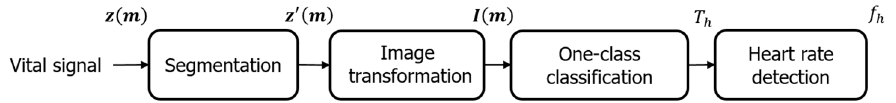
Figure 4. Block diagram of signal segmentation and HR detection process.